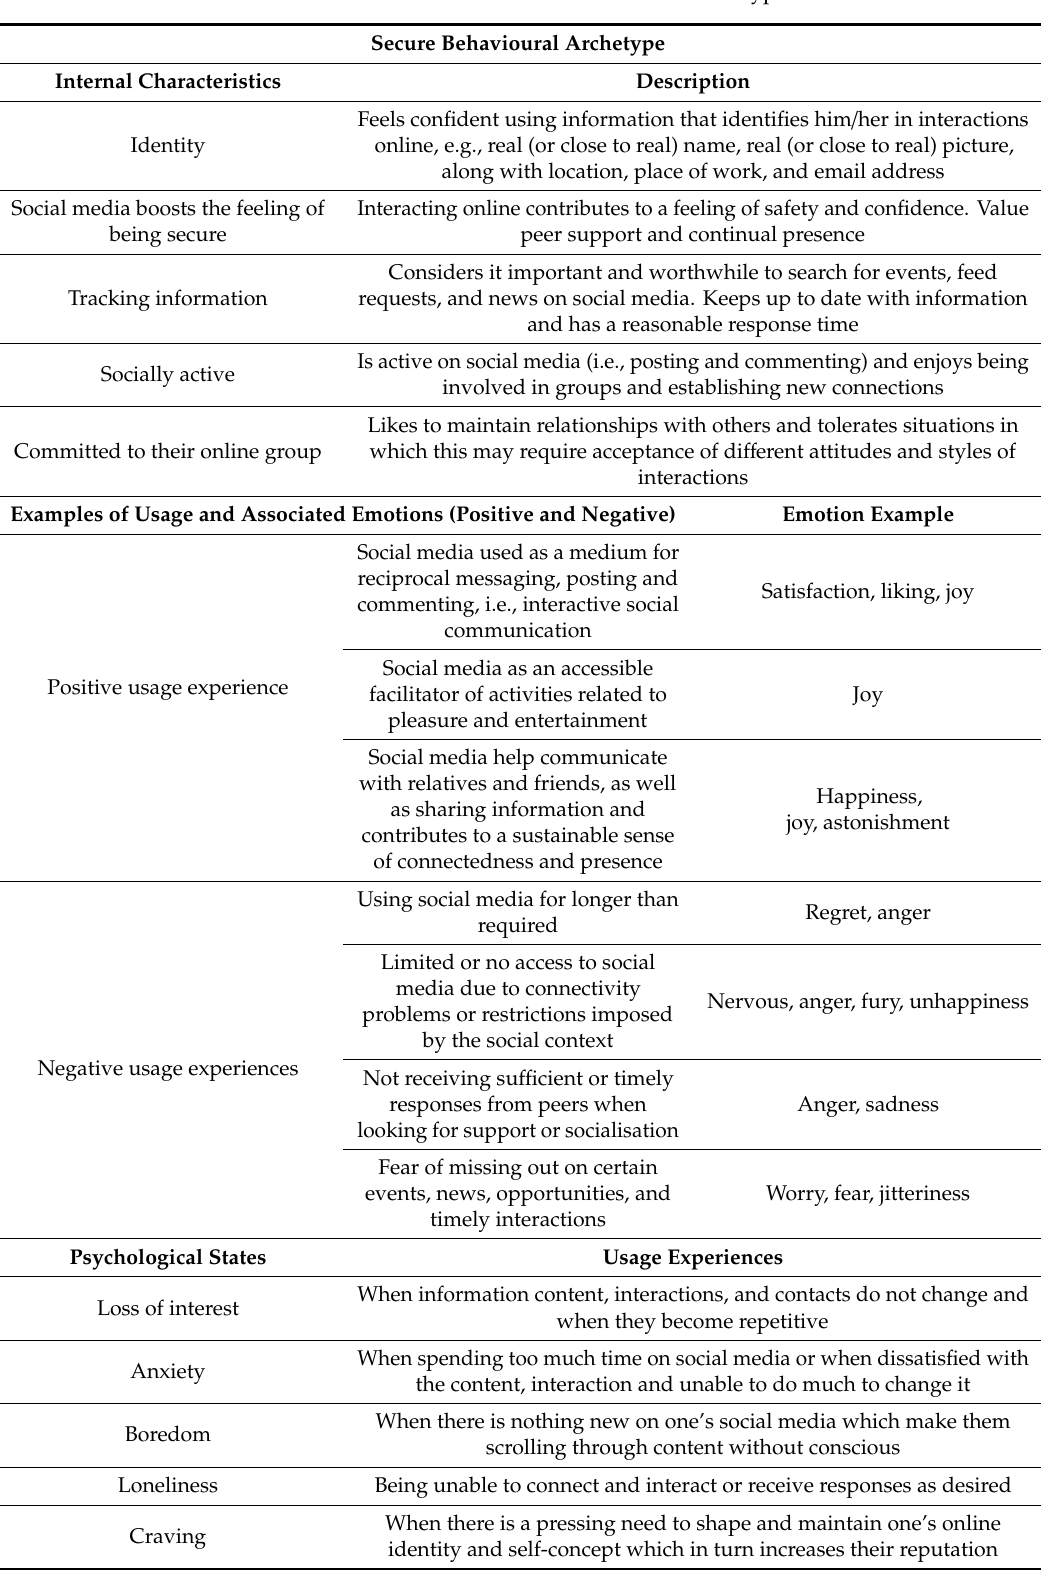
Table 5. Overview of the Secure behavioural